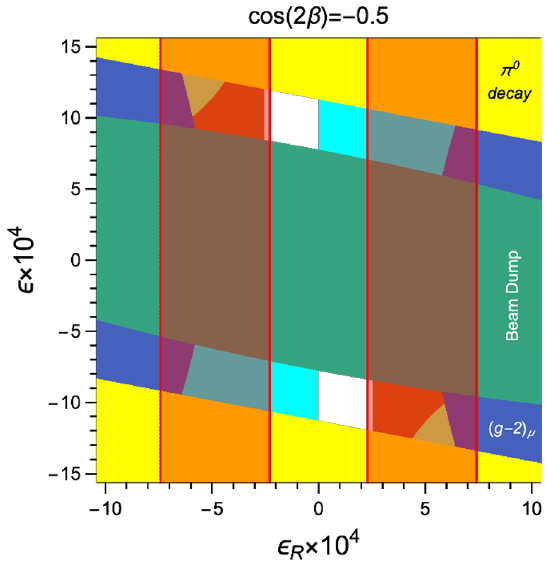
Figure 4 . The same figure as figure 3 in Model